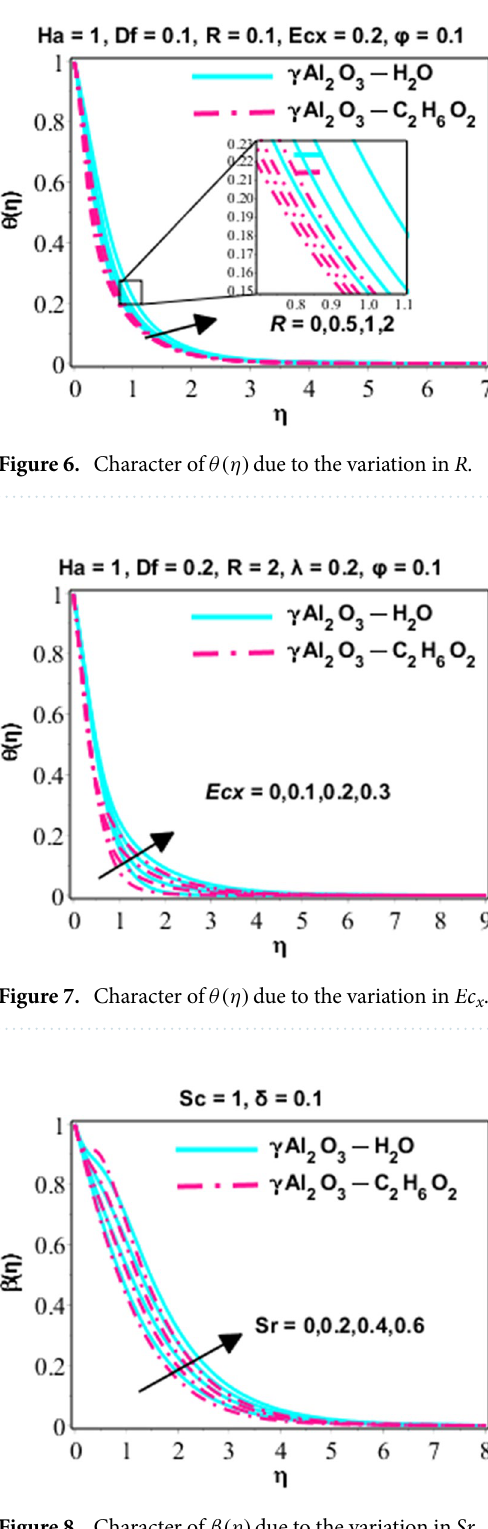
Figure 8. Character of β ( η ) due to the variation in Sr